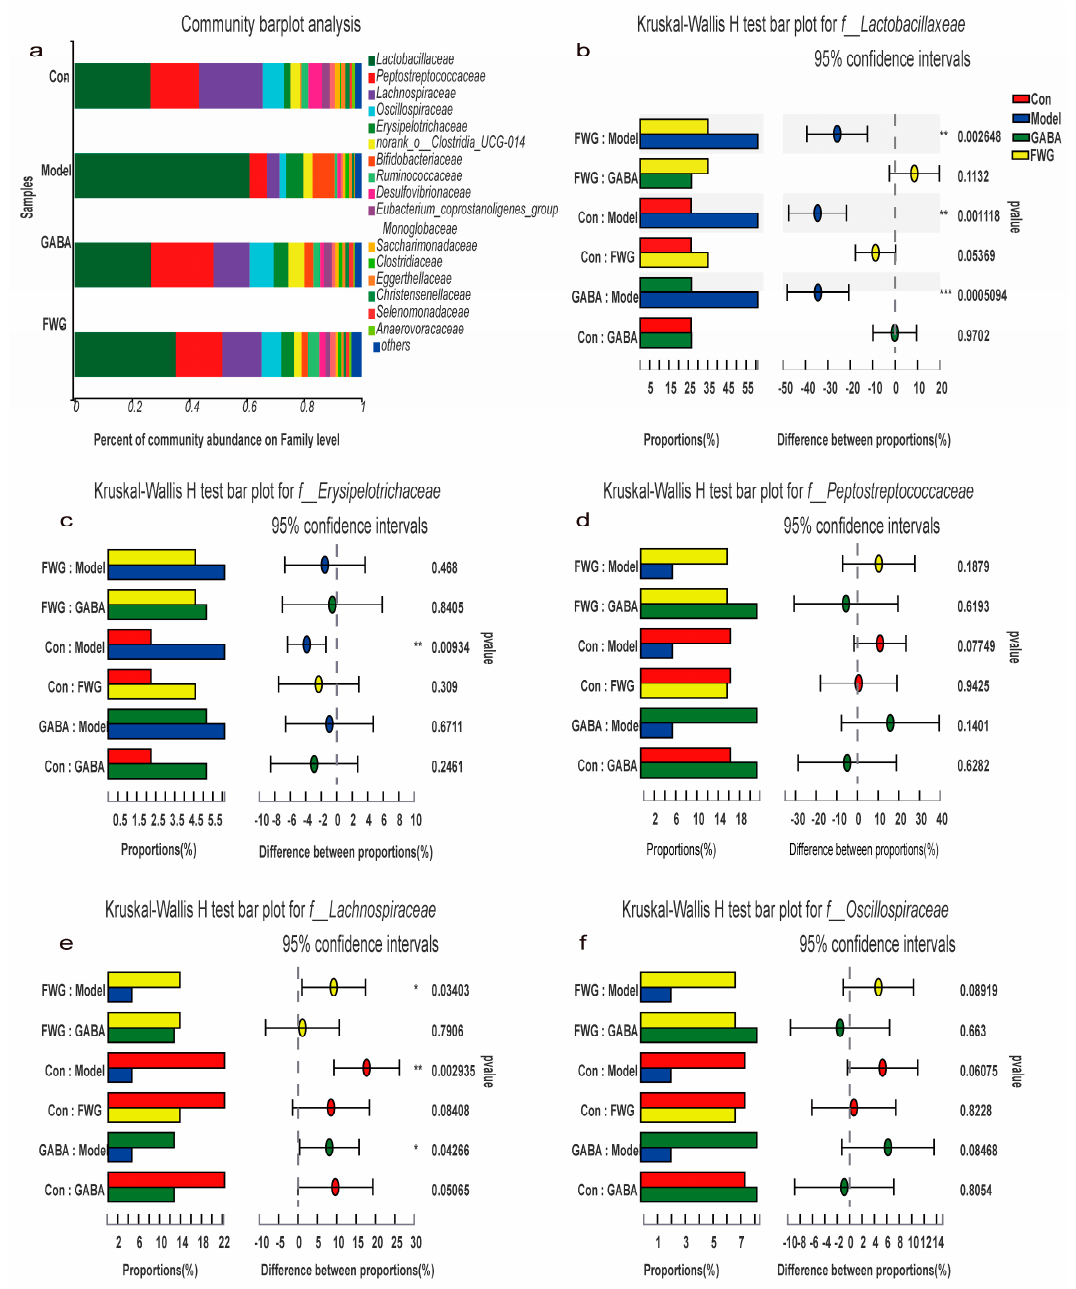
Figure 5. Differences in the species composition of gut microorganisms at the family level in different groups of samples. ( a ) Community bar–pot analysis at the family level. ( b ) Wilcoxon rank–sum test post hoc plots for Lactobacillaceae . ( c ) Wilcoxon rank–sum test post hoc plots for Erysipelotrichaceae . ( d ) Wilcoxon rank–sum test post hoc plots for Peptostreptococcaceae . ( e ) Wilcoxon rank–sum test post hoc plots for Lachnospiraceae . ( f ) Wilcoxon rank–sum test post hoc plots for Oscillospiraceae . (* p < 0.05, ** p < 0.01, *** p < 0.001 indicates a statistically significant difference.)